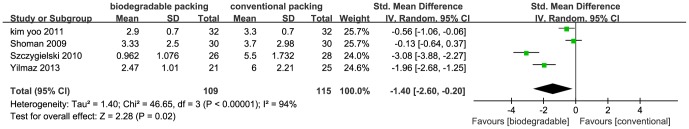
Forest plot of comparison: pain in situ (biodegradable packings versus conventional packings).